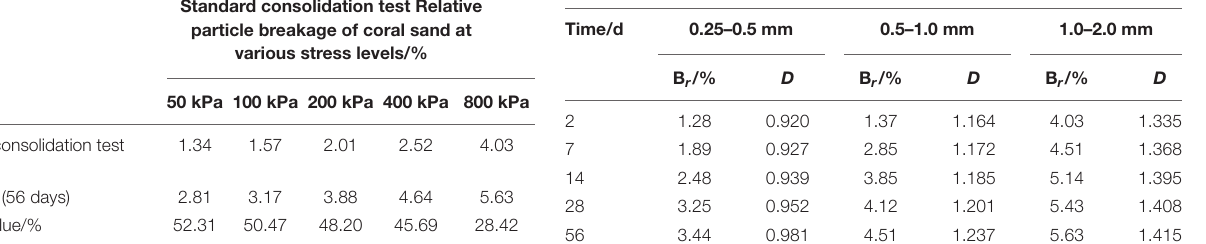
TABLE 5 | Relative particle fragmentation rate in coral sand test (1–2 mm). TABLE 6 | Relative particle breakage rate and Fractal dimension at the stress level of 800